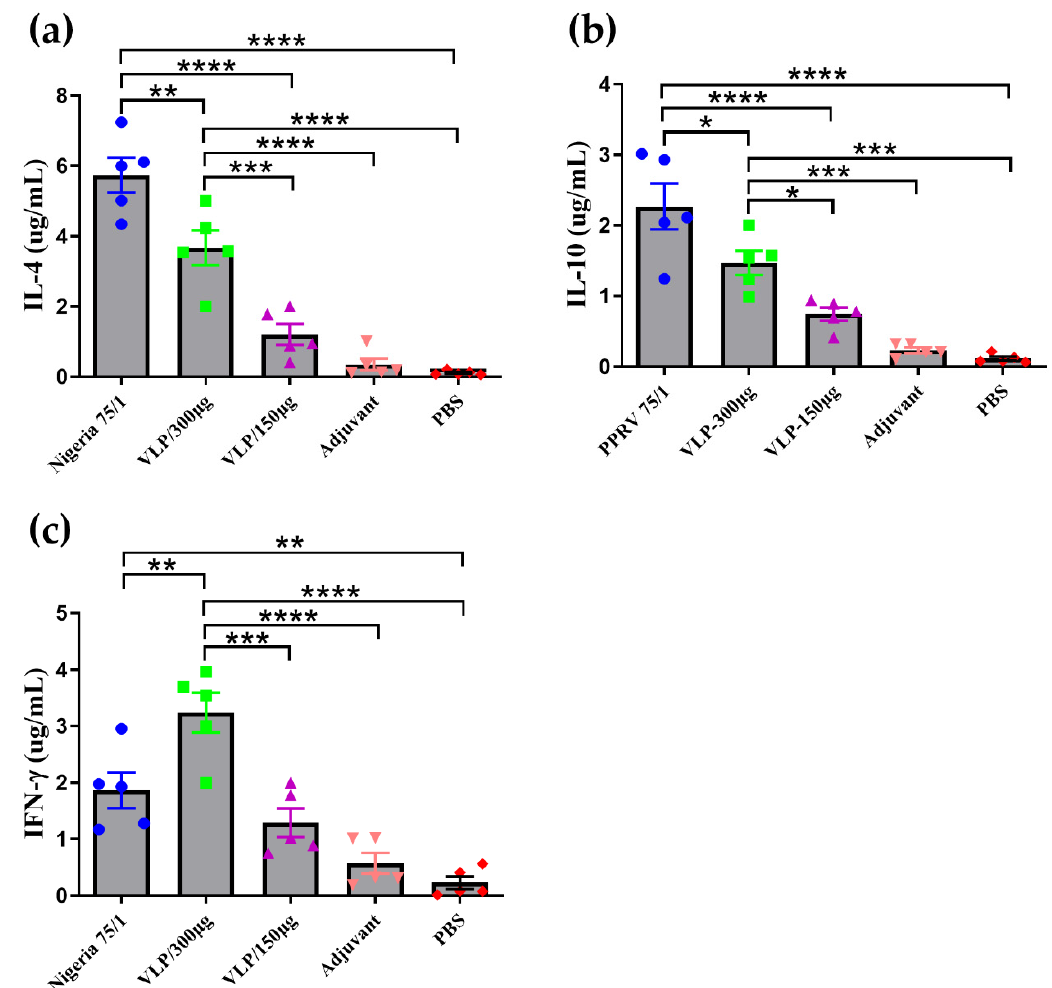
Figure 7. Immunization induces a significant cytokine response in goats. ( a–c ) Serum samples after the second immunization from animals immunized with PPRV VLPs (150 µ g or 300 µ g), PPRV Nigeria 75/1, PBS, or alum adjuvant were analyzed for IL-4 (a), IL10 (b) and IFN- γ (c). Significant differences were analyzed by one-way ANOVA and indicated as follows: * P < 0.05, ** P < 0.01, *** P < 0.001, **** P < 0.0001.